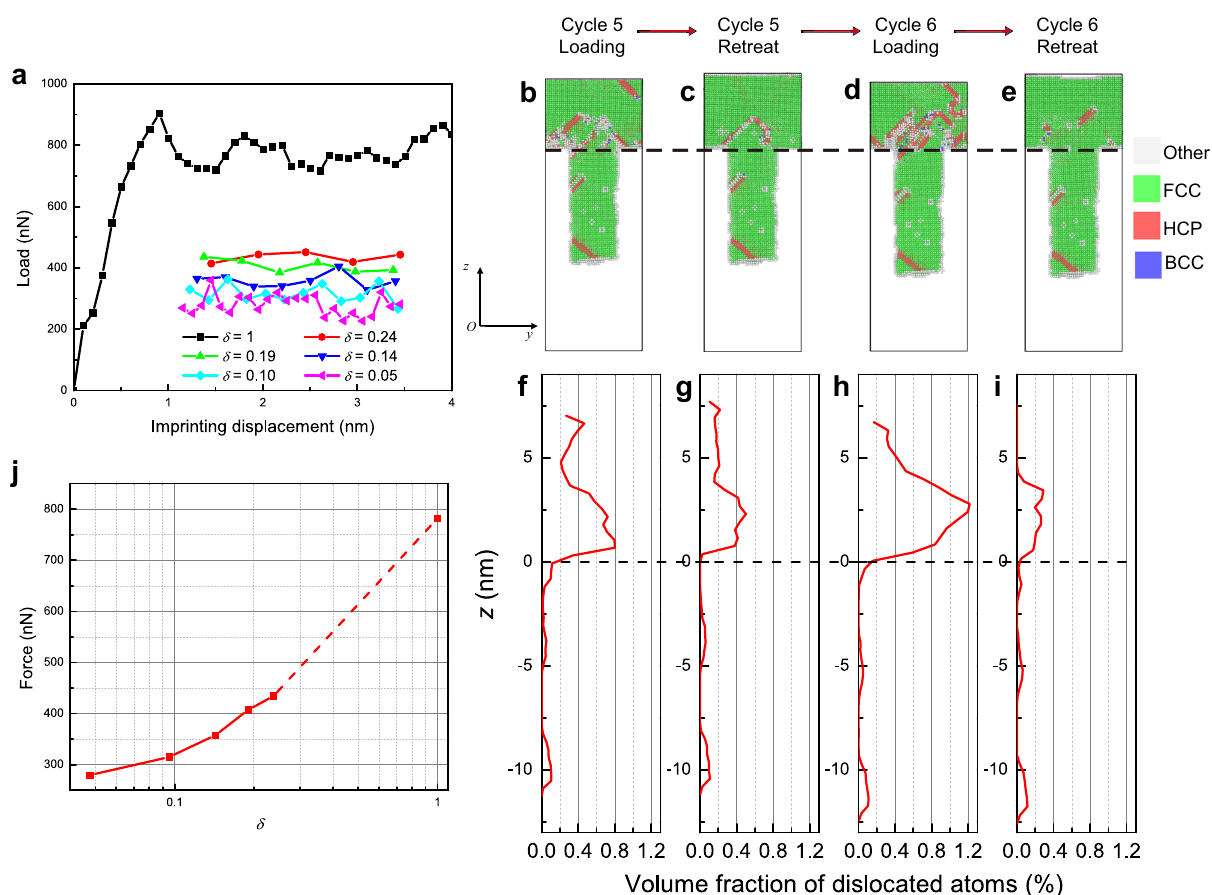
Fig. 3 Atomistic simulations of nanoimprinting on silver substrate under direct ( δ = 1) and cyclic (0 < δ < 1) loading patterns. a Load-imprinting displacement curves. Under direct loading ( δ = 1), the imprinting load is monitored every 0.1 nm of the displacement. Under cyclic loading (0 < δ < 1), the imprinting load is de fi ned as the mean force during each loading half-cycle. b – e Sectional views of the deformed silver substrate at imprinting cycles 5 and 6 under δ = 0.14. Atoms are colored according to their local lattice symmetry. f – i Volume fraction of dislocated atoms (HCP and BCC type) along the length ( z -axis) of the imprinted nanowire at moments corresponding to ( b – e ). The dashed lines in ( f – i ) and in ( b – e ) indicate the position z = 0. j the steady-state mean imprinting force as a function of the loading